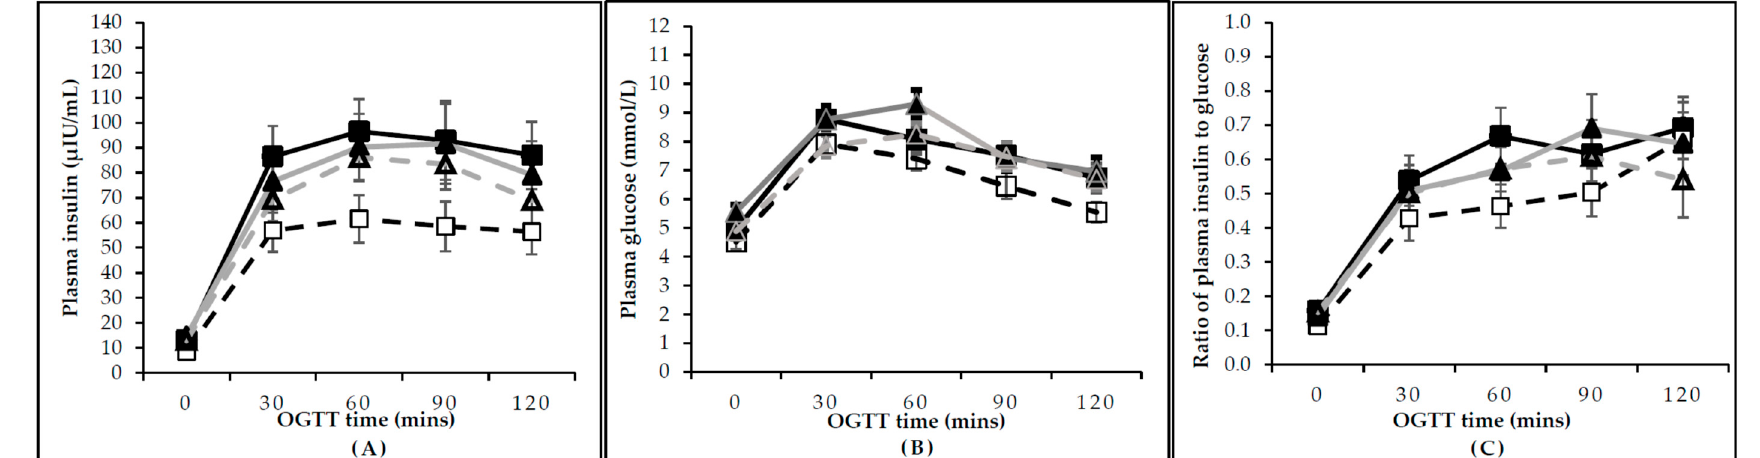
Figure 2. Plasma insulin and glucose responses to a standard 75-g OGTT before and after 16-week of intervention in the pulse-based diet and TLC diet groups. Solid dark lines represent women in the pulse-diet group at baseline ( n = 30). Solid light lines represent women in the TLC diet group at baseline ( n = 29). Dotted dark lines represent women in the pulse-diet group after the intervention ( n = 30). Dotted light lines represent women in the TLC diet group after the intervention ( n = 29). Insulin time course in response to OGTT ( A ); glucose time course in response to OGTT ( B ); ratio of plasma insulin to glucose time course in response to OGTT ( C ). Groups were comparable at baseline. Data are expressed as mean ± SEM. Abbreviations: OGTT, oral glucose tolerance test.